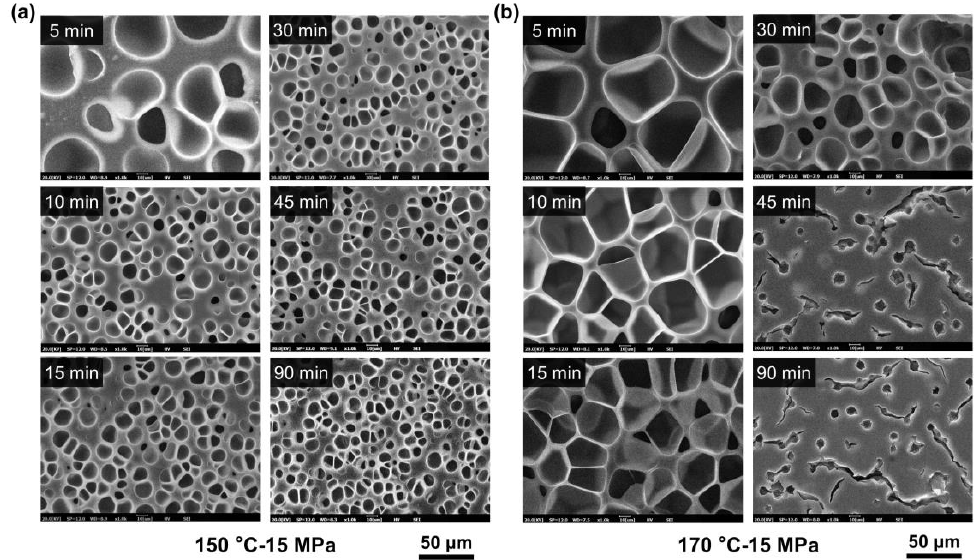
Figure 9. Cell morphology evolution of HD-TPU foams prepared at ( a ) 15 MPa/150 °C and ( b ) 15 ( b ) 15 MPa/170 ◦ C for different saturation MPa/170 °C for different saturation times.